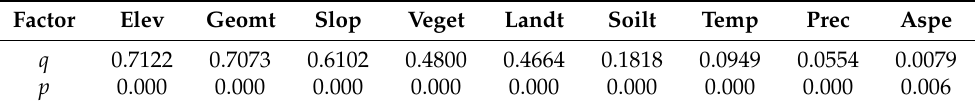
Table 5. The q value of each driving